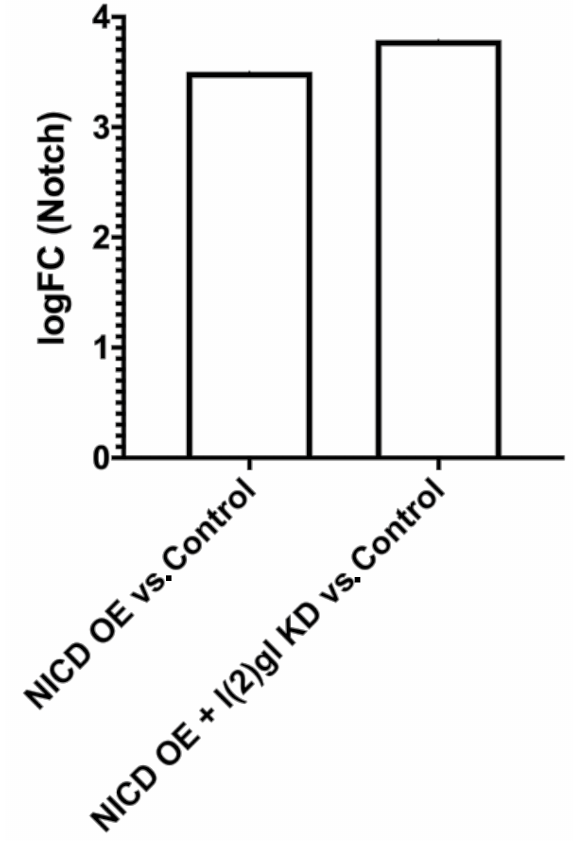
Figure A3. Comparable levels of Notch expression (dosage) between NICD OE and NICD OE + l(2)gl KD genotypes compared to Control. LogFC Notch expression between NICD OE and NICD OE + l(2)gl KD compared to Control from bulk RNA sequencing experiment.